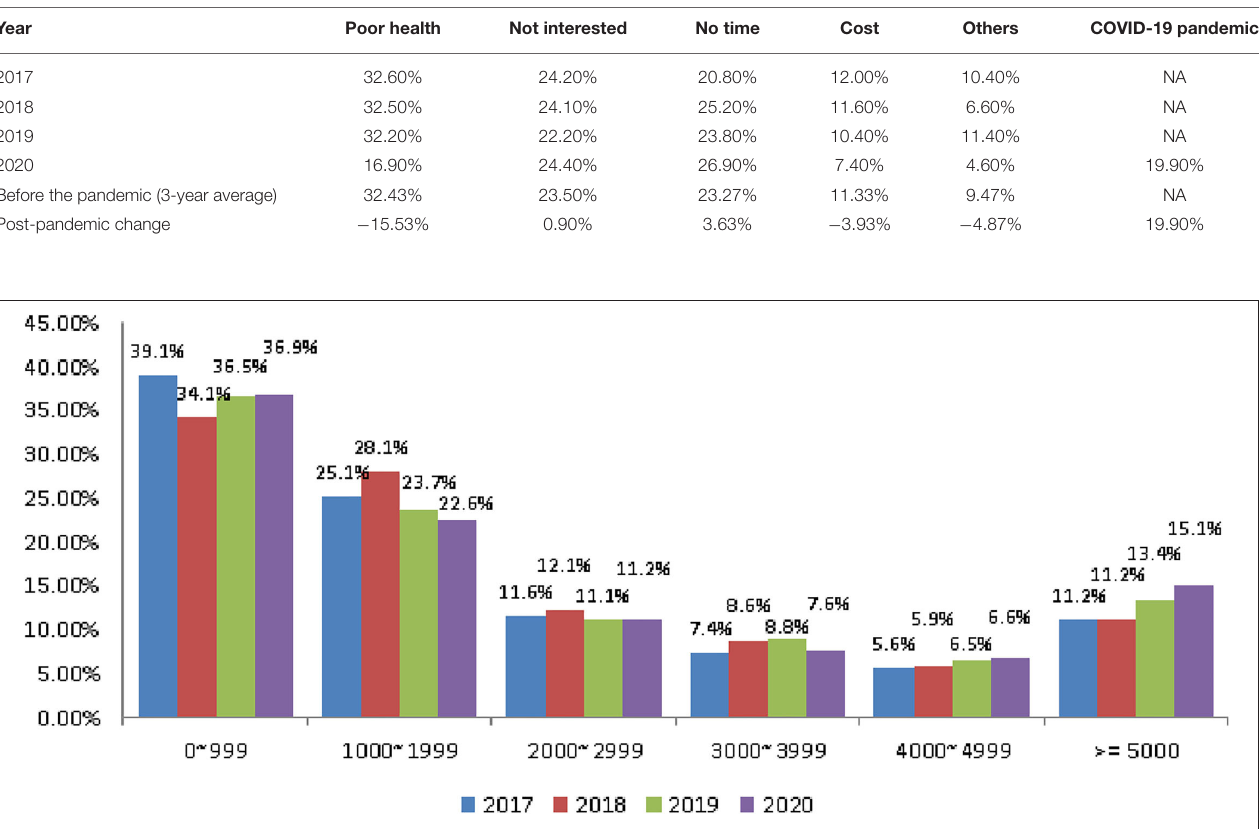
Frontiers in Public Health |